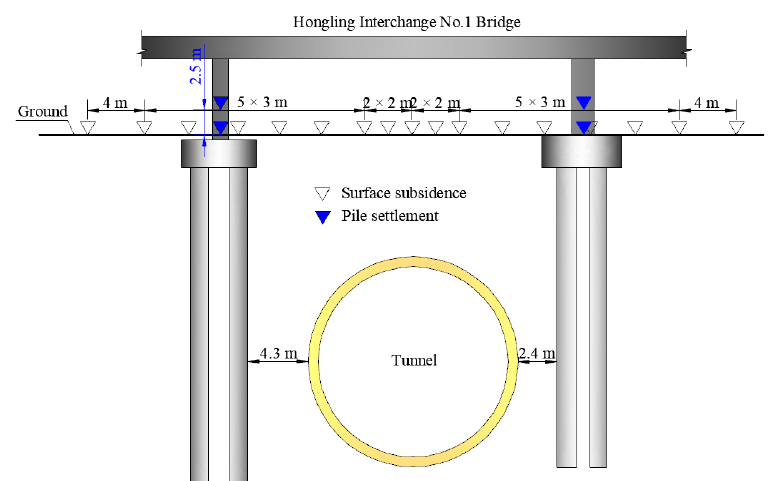
Figure 11. Layout of monitoring points.